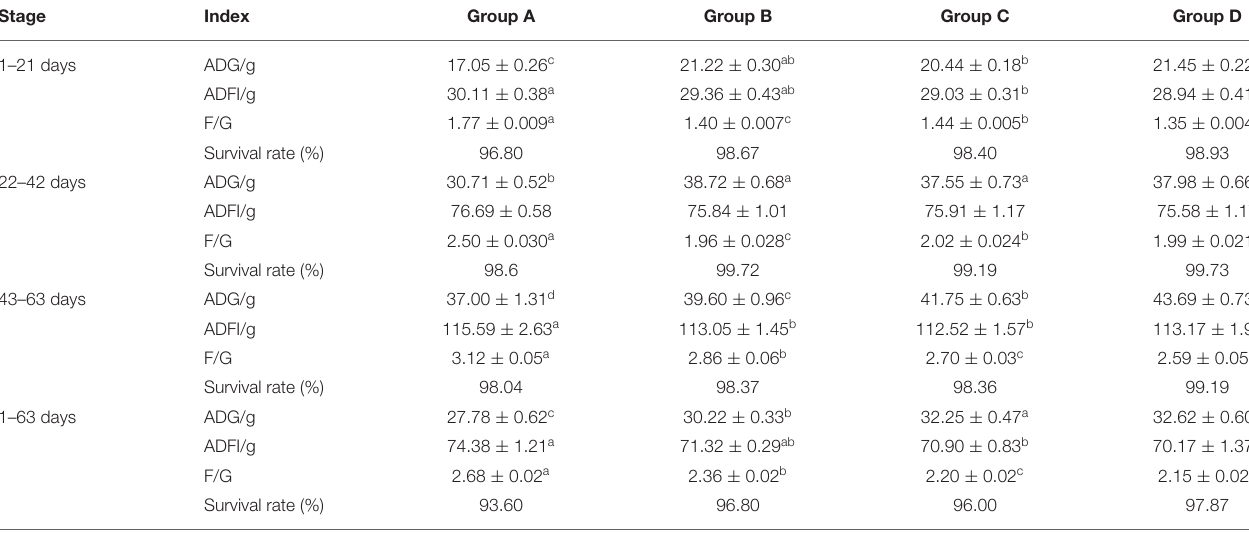
TABLE 4 | The growth performance of yellow-feathered chickens in different treatment groups. Stage